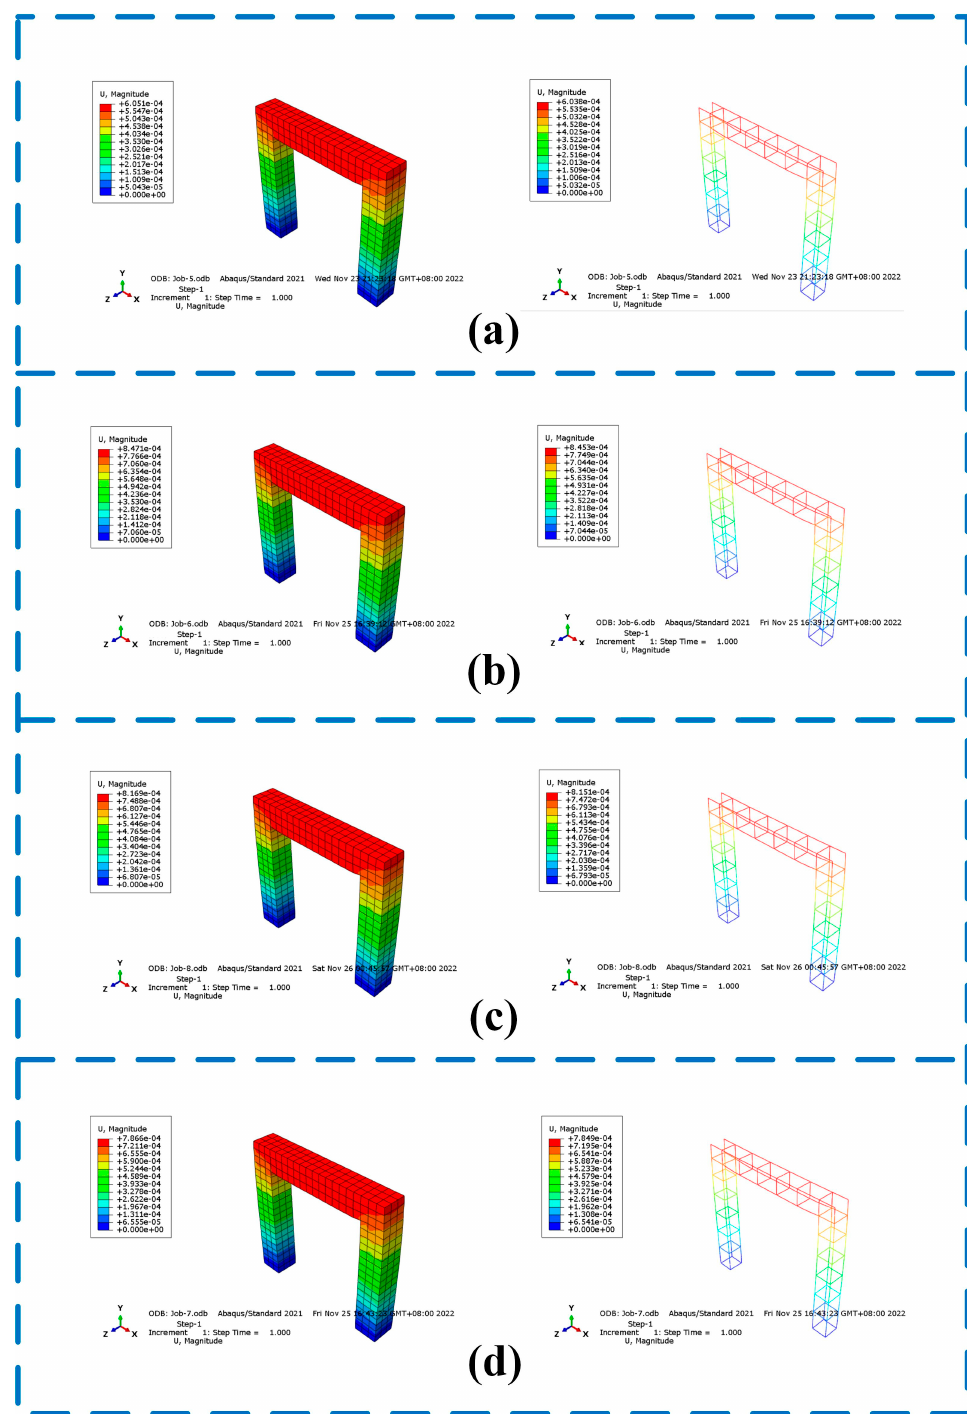
Figure 12. Displacement clouds of four frame structures: ( a ) ordinary concrete frame model; ( b ) rubber concrete frame model; ( c ) PVA rubber concrete frame model; ( d ) modified PVA rub- ber concrete frame